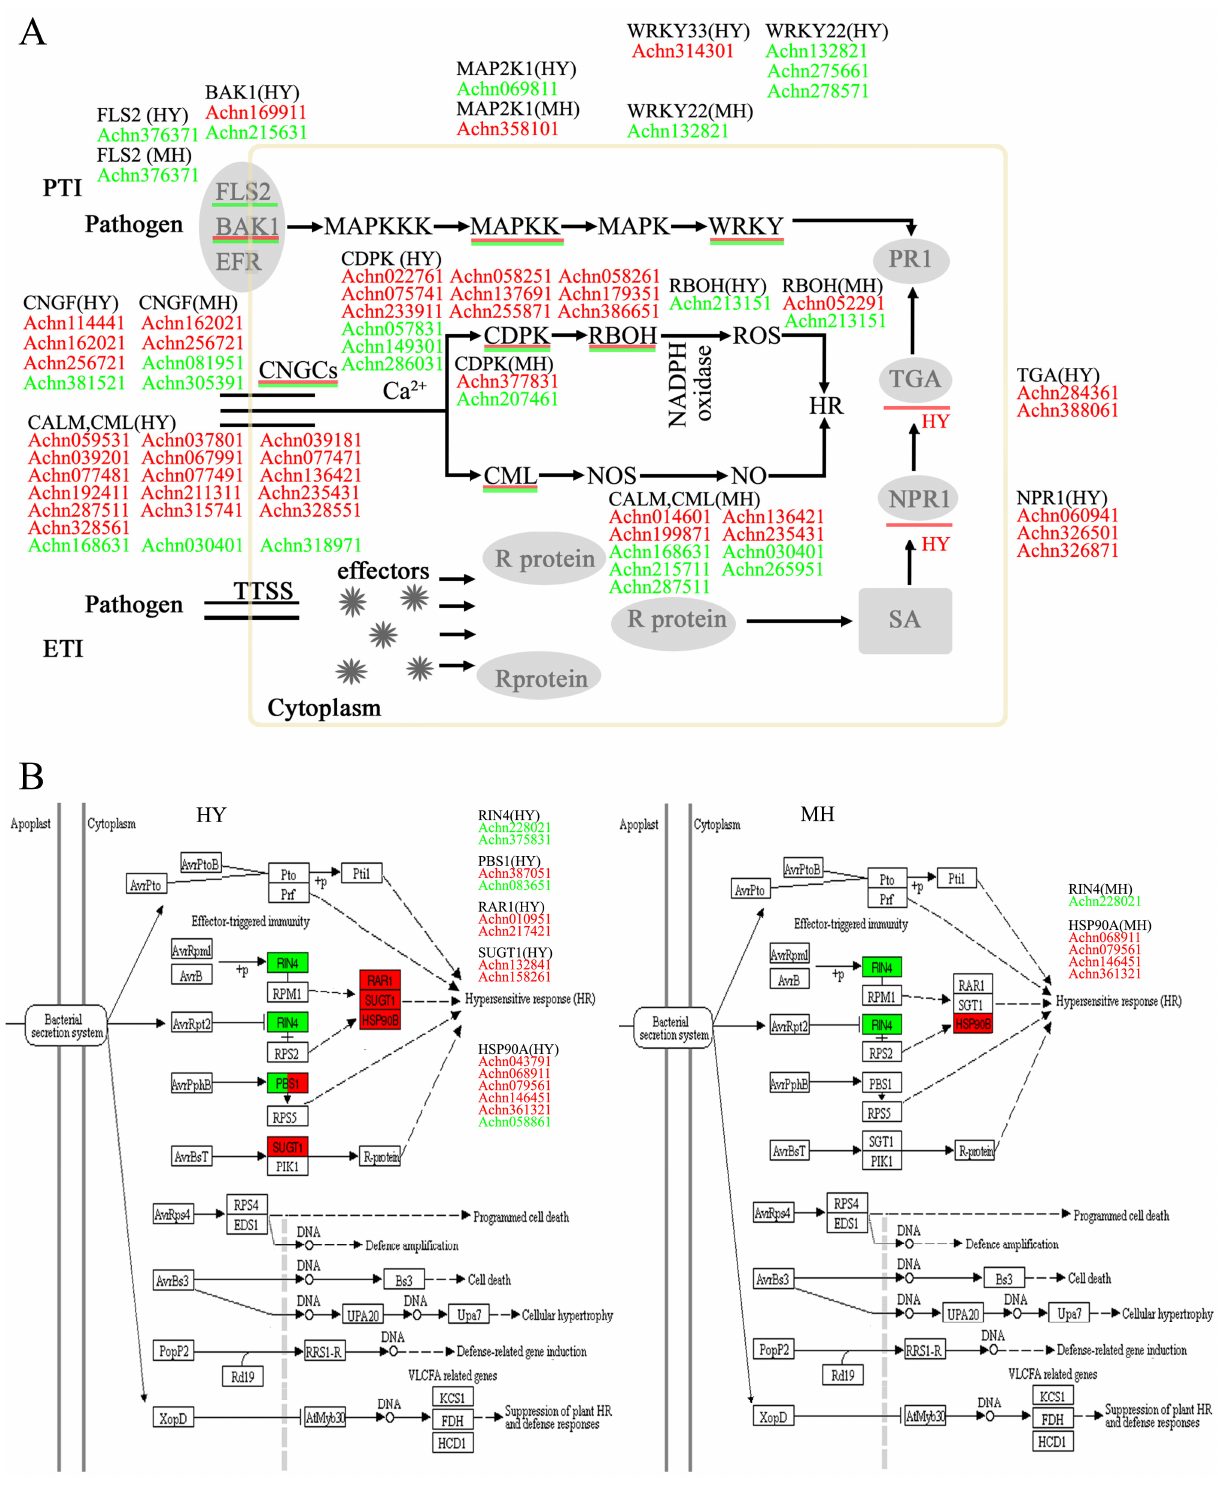
Figure 4. Expression patterns of the DEGs involved in PTI and ETI in response to Psa infection in MH and HY. ( A ) Schematic diagram of the plant’s innate immune-system response to Psa inoculation. ( B ) Expression patterns of the DEGs involved in ETI between MH and HY. Gene-expression level was measured using the FPKM method (expected number of fragments per kilobase of transcript sequence per millions of base pairs sequenced). The map shows the expression of genes in red (up-regulated expression) and green (down-regulated